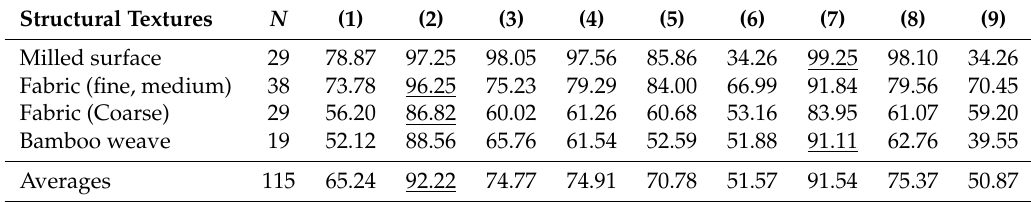
Table 6. Numerical values obtained using different thresholding methods on structural textures: (1) the average method, (2) the MiMa method, (3) the Riddler method, (4) the Thrussel method, (5) the